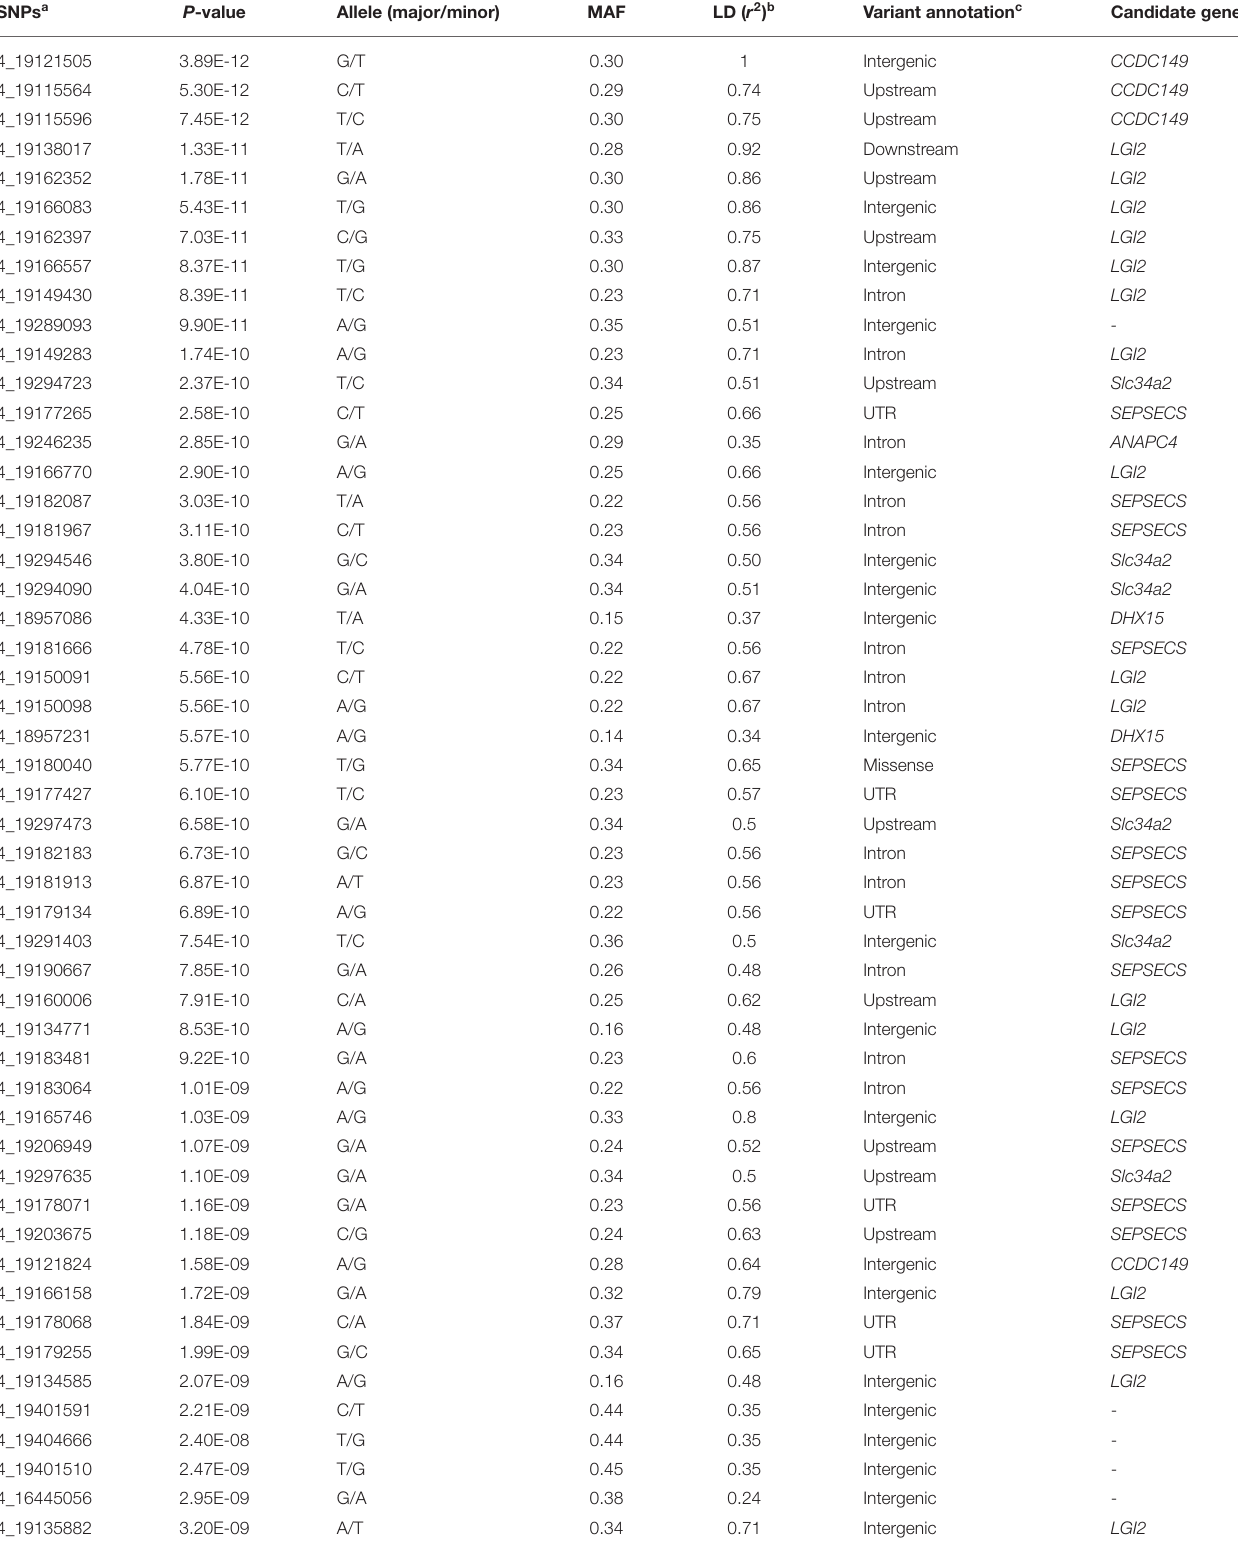
TABLE 1 | Summary of significant SNPs that are associated with the beak length trait. SNPs a P -value Allele (major/minor) MAF LD ( r 2 ) b Variant annotation